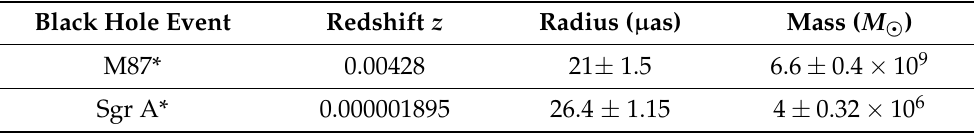
Table 1. Compilation of the BH events and their observations (data from [8,9]). The first column denotes the BH event and its reference; the second column, the z at which they were observed; the third and fourth columns, the radius in microarc-second ( µ as) and the mass in solar masses units ( M (cid:12) ) of the BH event,